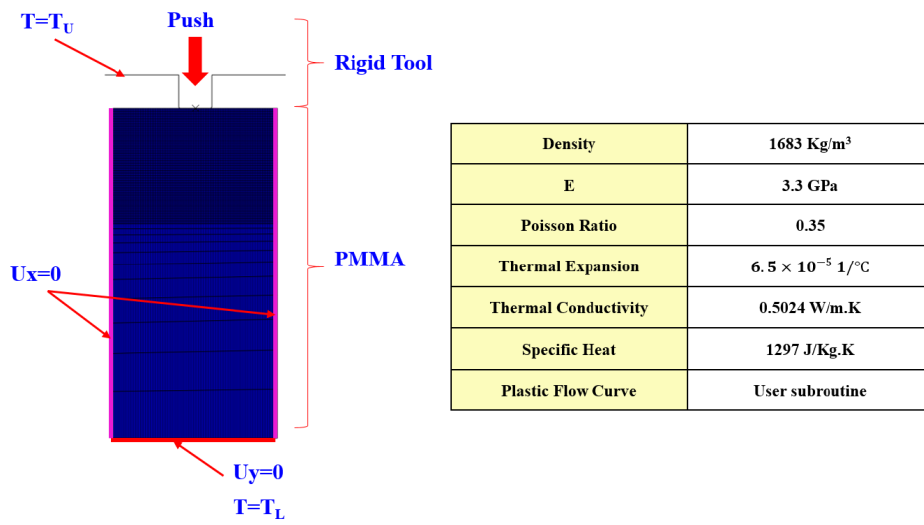
Figure 7. Analysis model and material properties.